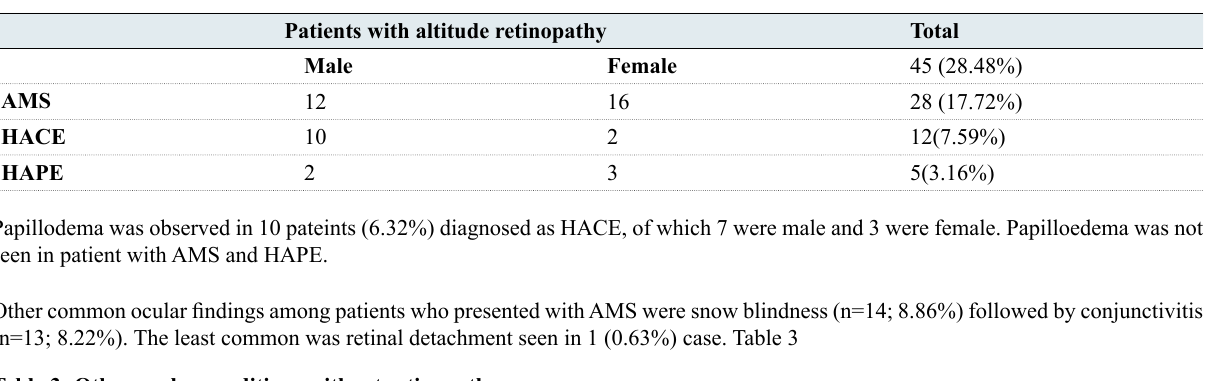
Table 3: Other ocular conditions without retinopathy Ocular Conditions